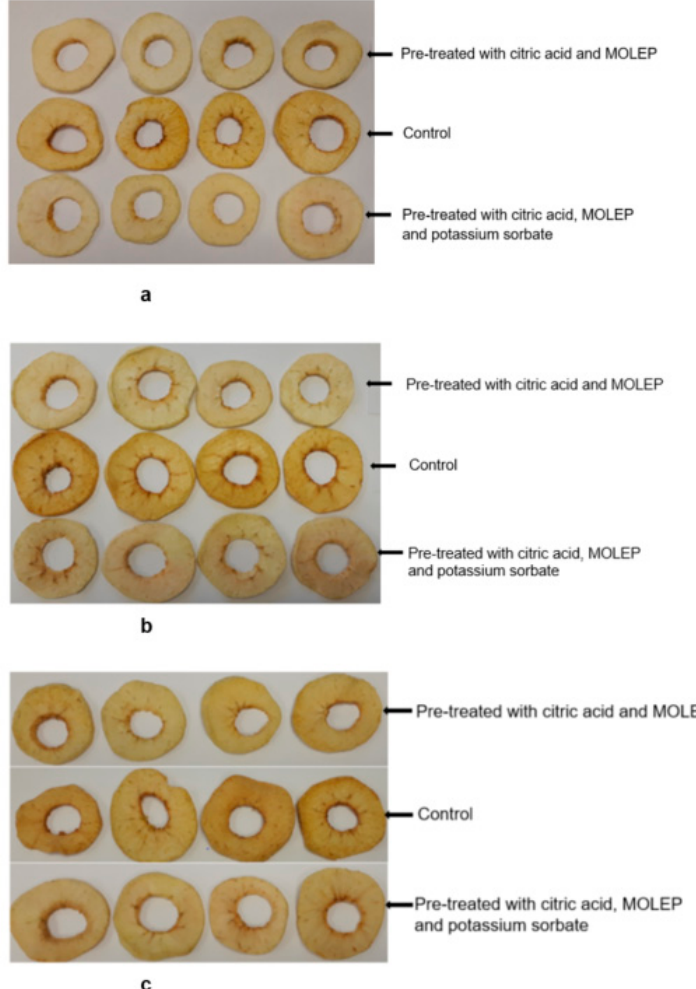
Figure 2 . Image of untreated and pre-treated dried apple slices at storage time ( a ) 0 days; ( b ) 60 days and ( c ) 120 days .